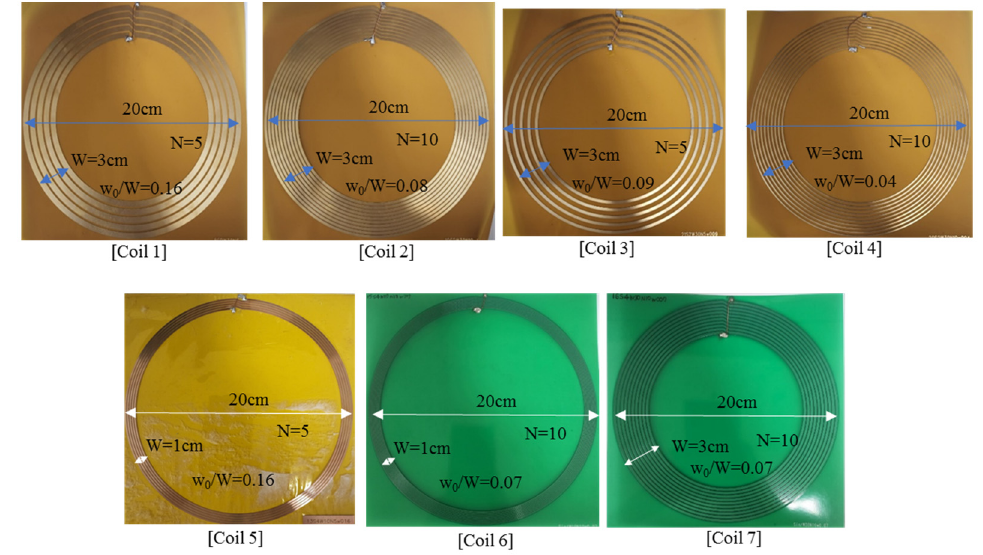
Figure 8. Photographs of coils optimized (coils 1, 2, 5, 6, and 7) for maximum Q-factor and fabricated coils that were not optimized (coils 3 and 4) to be compared with coils 1 and 2, respectively.